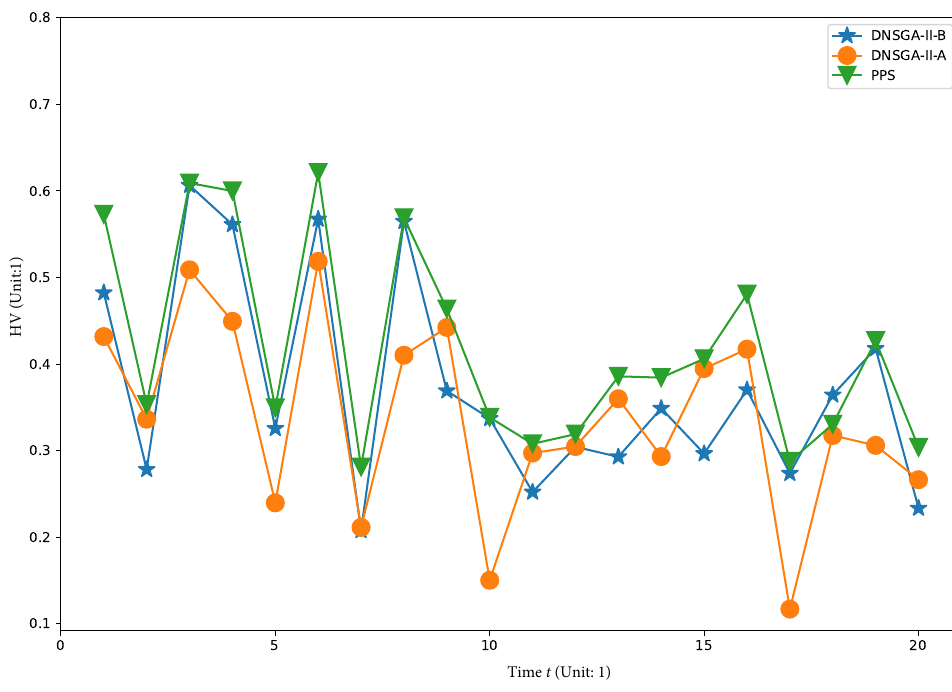
Figure 11. Obtained HV of three algorithms with τ t = 10.